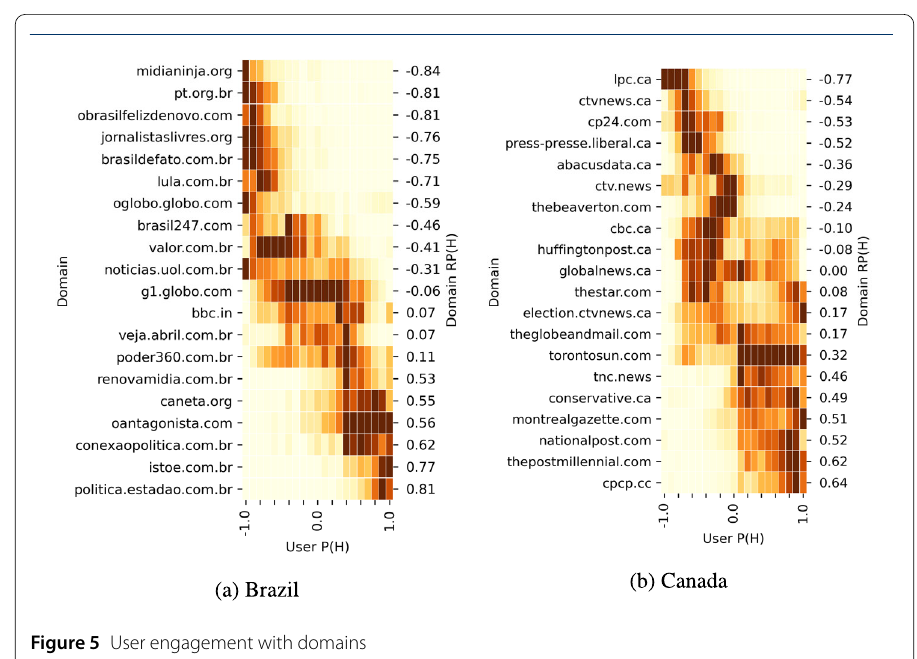
Figure 5 User engagement with domains